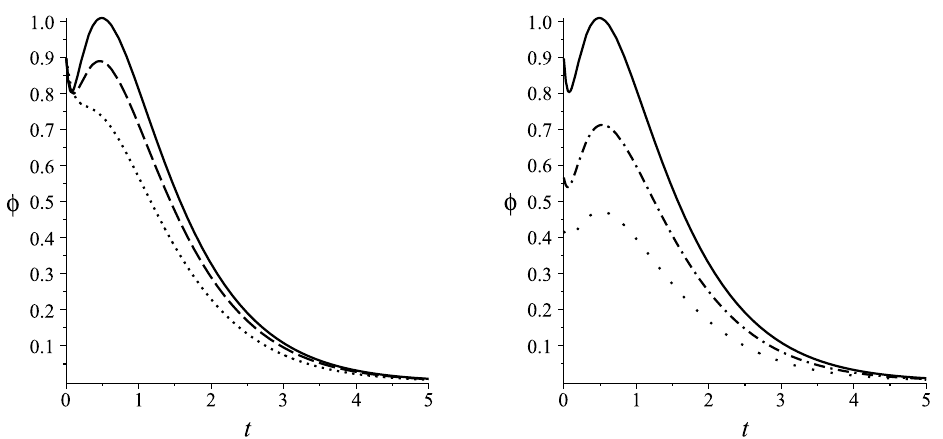
Figure 1 . Plots of ’ ( t ) for di(cid:11)erent values of the constants C u takes the following values: C u = 5 (solid line), C u 2 the right , C u = 5 and C u takes the following values: C u 2 1 line) and C u = 4 (space-dotted line). Note that the solid lines on the left and right sides are the 1 same